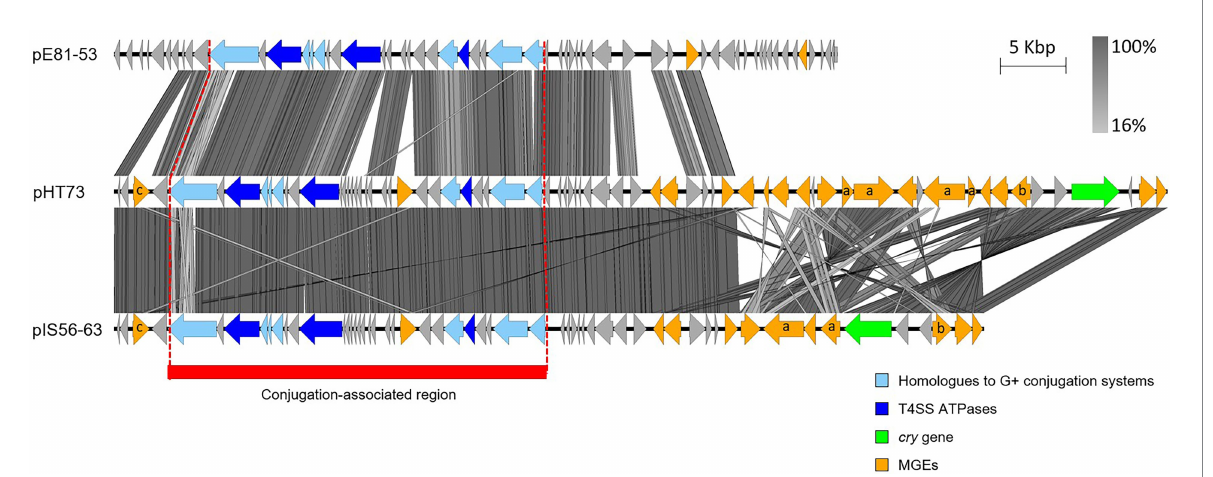
FIGURE 3 Sequence comparison of the (putative) conjugative plasmids similar to pHT73. The conjugation-associated region of the plasmids pHT73, pE81-53 and pIS56-63 share evident similarities. CDS depicted in light blue share homologies with other known conjugative systems; CDS depicted in dark blue are the putative ATPases; CDS in orange correspond to different types of MGEs (a = Tn/ b = group II intron / c = recombinase / no annotation = IS); CDS in green encode Cry toxins. The region highlighted in red corresponds to the region associated with conjugative functions. The image was generated by Easyfig 2.0 software. Genbank accession numbers: Table